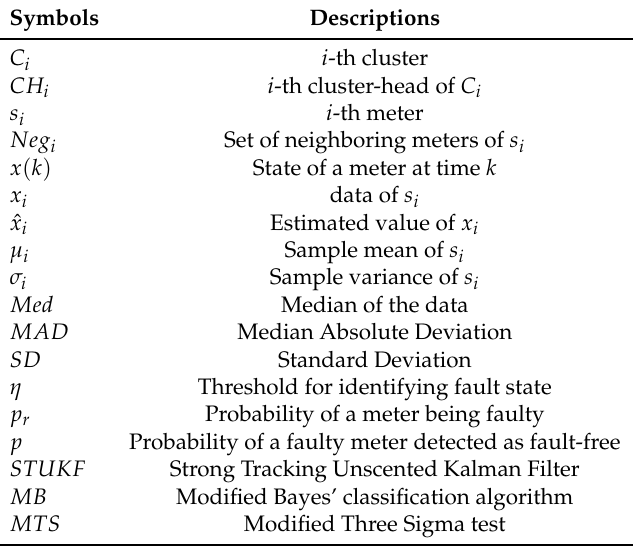
Table 1. Notions.